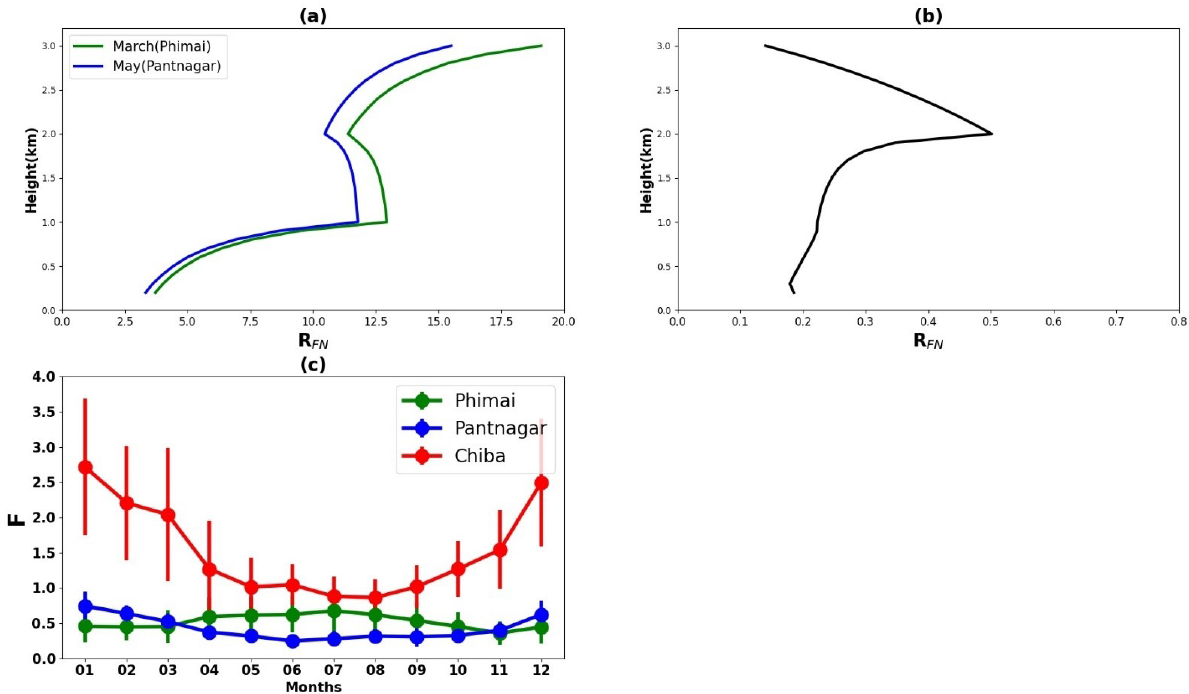
Figure 6. Seasonal mean R FN profiles during (a) March and May at Phimai and Pantnagar, respectively, and (b) February at Chiba. (c) Sea- sonal variations in the column-to-surface conversion factor ( F ) for the Phimai, Pantnagar, and Chiba sites, estimated from the CHASER- simulated HCHO and NO 2 surface concentrations and VCD. The simulated data from 07:00–18:00LT in 2017 were used to estimate the F values. The error bars represent the 1 σ standard deviation of the mean values.